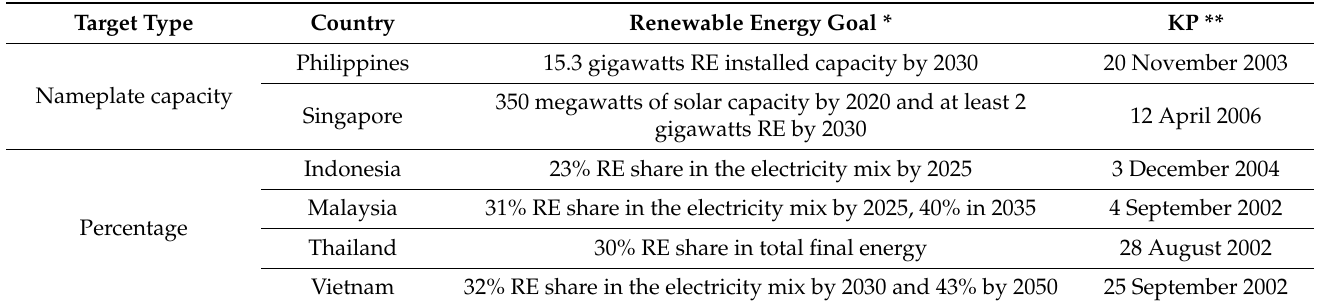
Table 1. Renewable energy goals and Kyoto Protocol (KP) ratification status by ASEAN states.